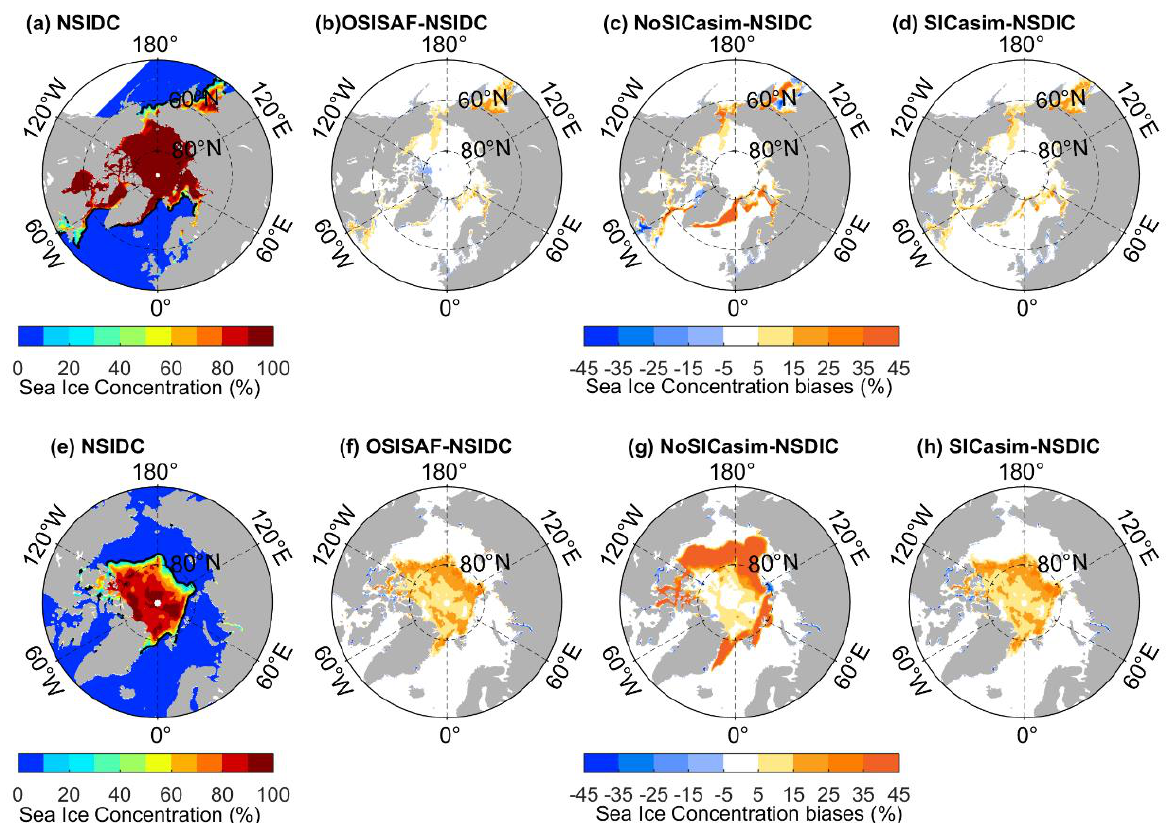
Figure 1. Arctic sea ice concentration from NSIDC ( a , e ) which is regarded as the “truth”, the biases of OSISAF ( b , f ) and model biases ( c , d , g,h ) of the Northern Hemisphere in March ( a – d ) and September ( e – h ), 2019.